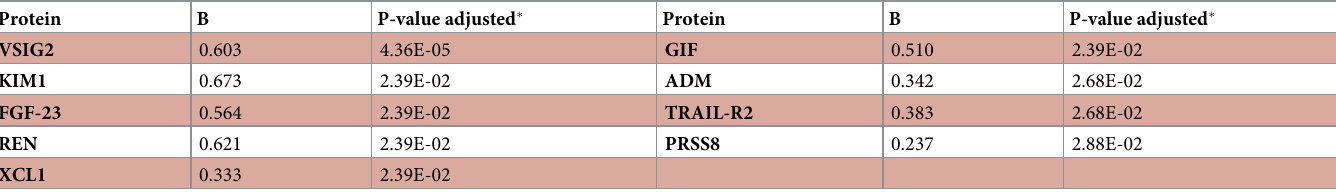
Table 4. Proteins significantly altered in subjects with a combined diagnosis compared with no combined diagnosis. Protein